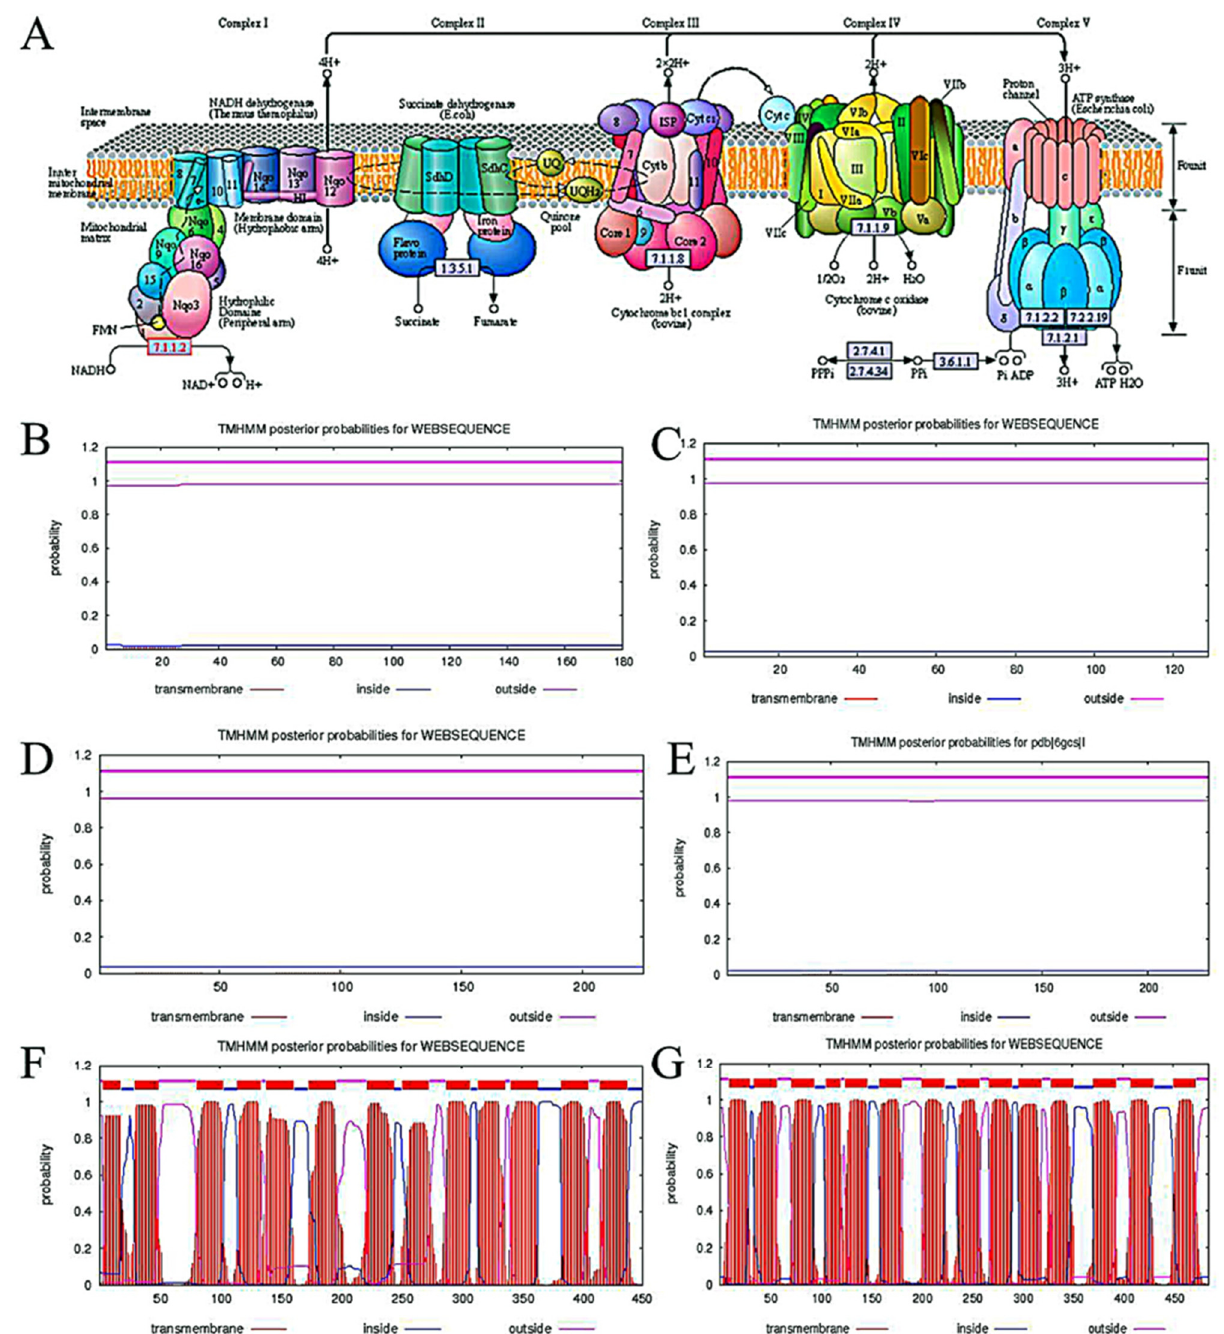
Figure 2. The ETC structure ( A ) and the predicted transmembrane helices of gene nuo I by TMHMM Server v. 2.0 in E. coli K-12 ( B ), C. beijerinckii NCIMB 8052 ( C ), Y. lipolytica ( D ) , gene monacsus _4971 in M. purpureus LQ-6 ( E ), that of gene nuo M ( F ) and nuo N ( G ) in E. coli K-12, respectively. Table 1. Comparison of the TMHMM results of gene nuo I in different strains.